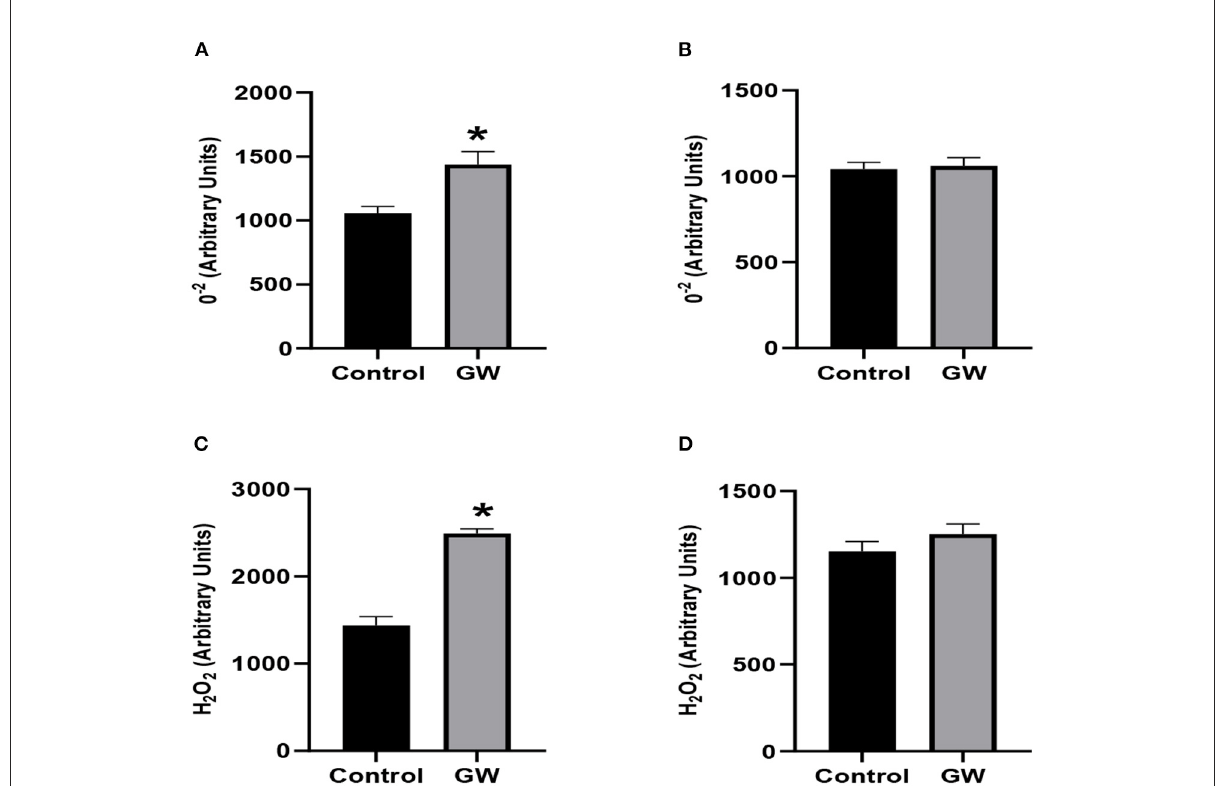
FIGURE13 Effect of endophytic fungus Fusarium oxysporum GW on the level of H 2 O 2 and O 2 − in the leaves of A. fatua weed (A,C) and wheat (B,D) . Bars labeled with * are significantly higher ( t -test; p <